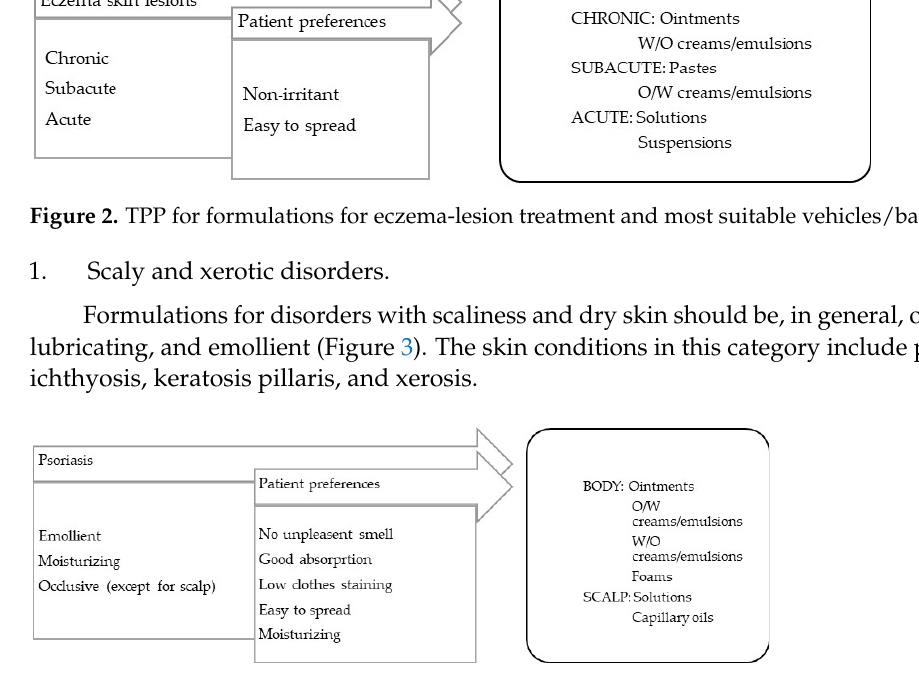
Figure 3. TPP for formulations for psoriasis treatment and most suitable